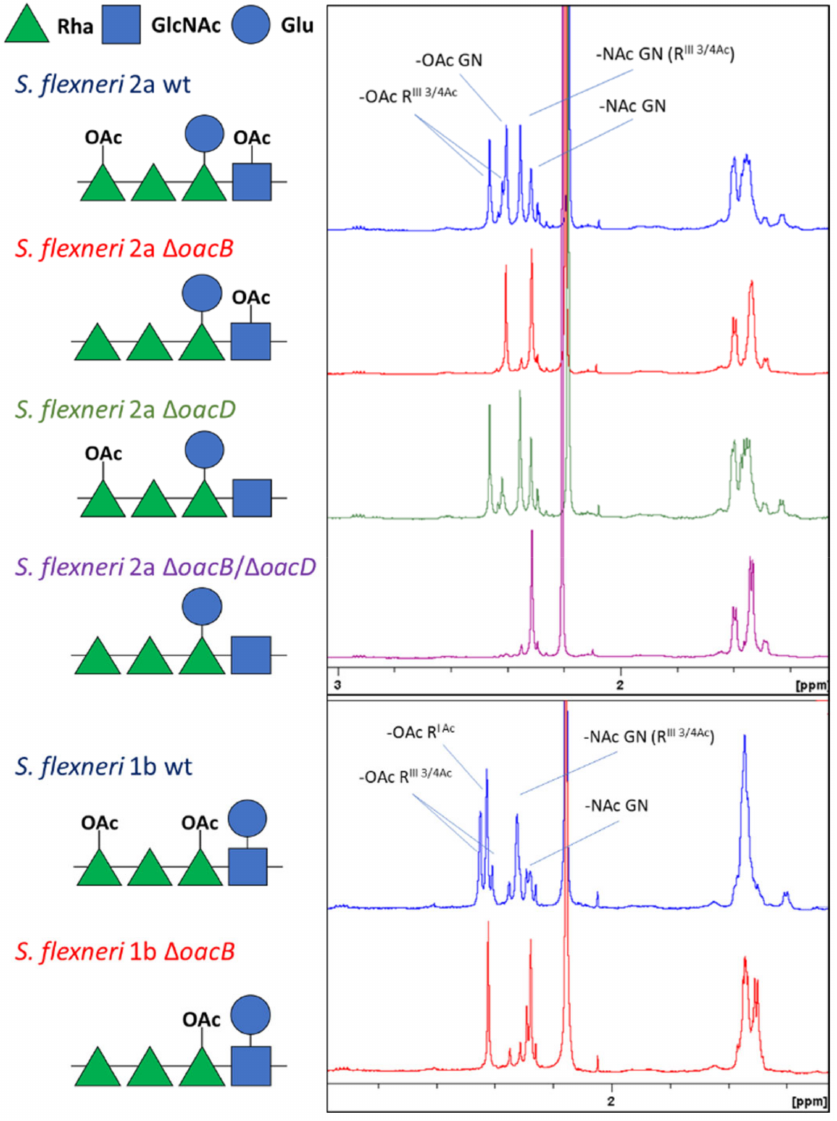
Figure 1. Schematic representation of differently O-acetylated S. flexneri 2a and 1b OAg structures generated in this study with the corresponding 1 H NMR spectra focusing on the OAc area. R = Rha, GN = GlcNAc. Complete 1 H NMR spectra are shown in Figure